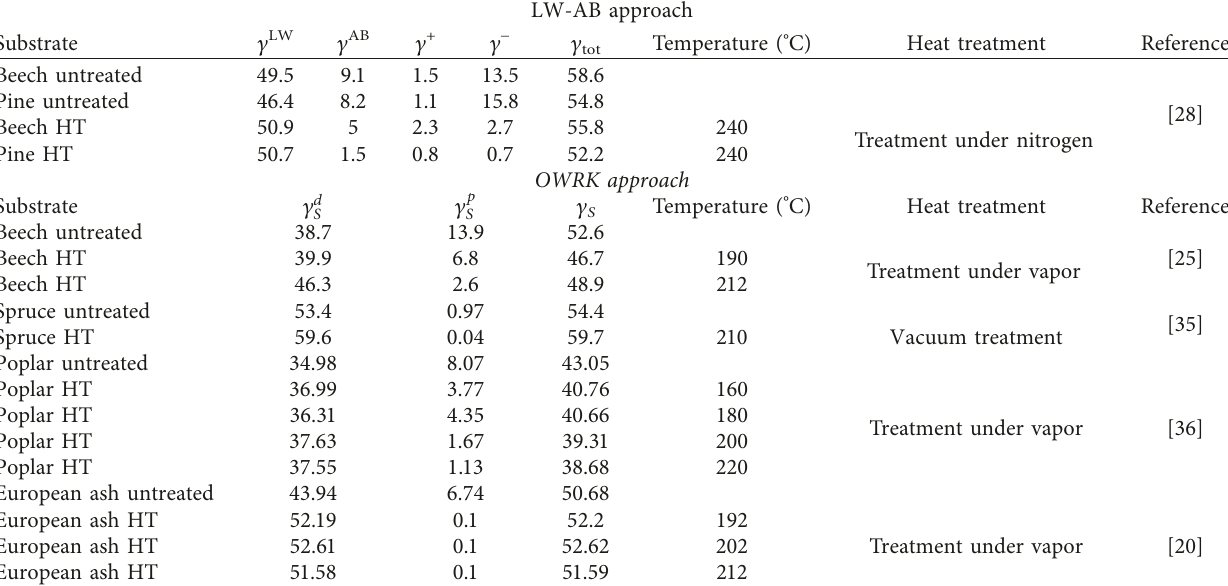
Table 2: Comparison of surface free energy of heat-treated (HT) and untreated wood